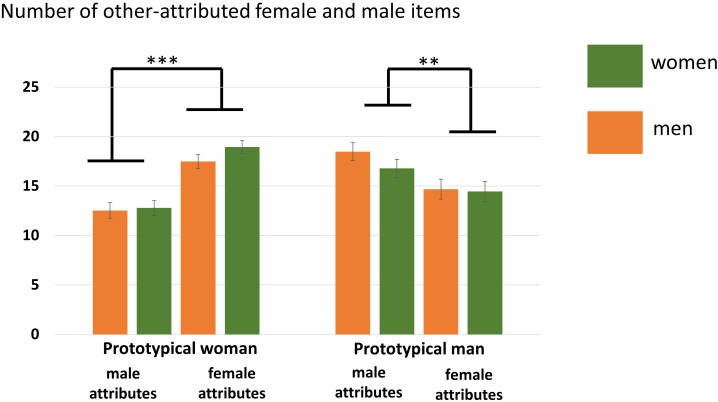
Number of agreed items in the other conditions separated for women and men. More female compared to male attributes were assigned to the prototypical female actor (Julia) while more male compared to female attributes were assigned to the prototypical male actor (Brad). Error bars indicate the standard error of the mean (SEM). ∗∗∗p < 0.001, ∗∗p < 0.01.